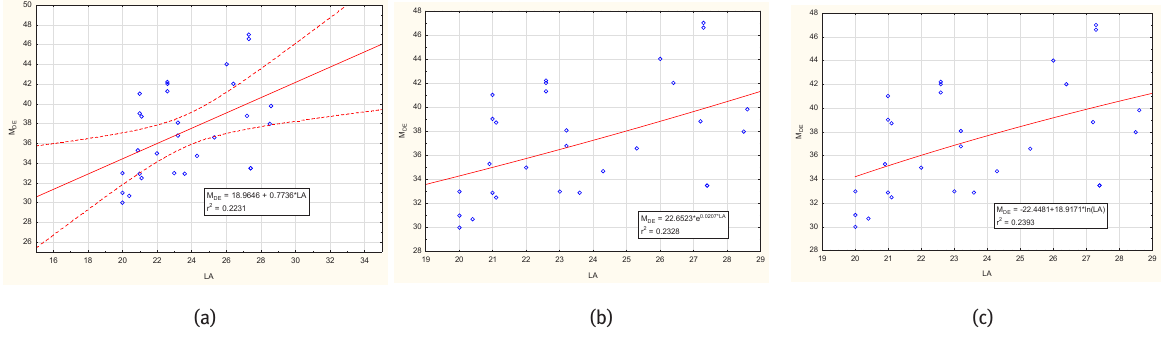
Fig. 7. Function fitting for Magura sandstone: (a) linear, (b) exponential and (c) logarithmic